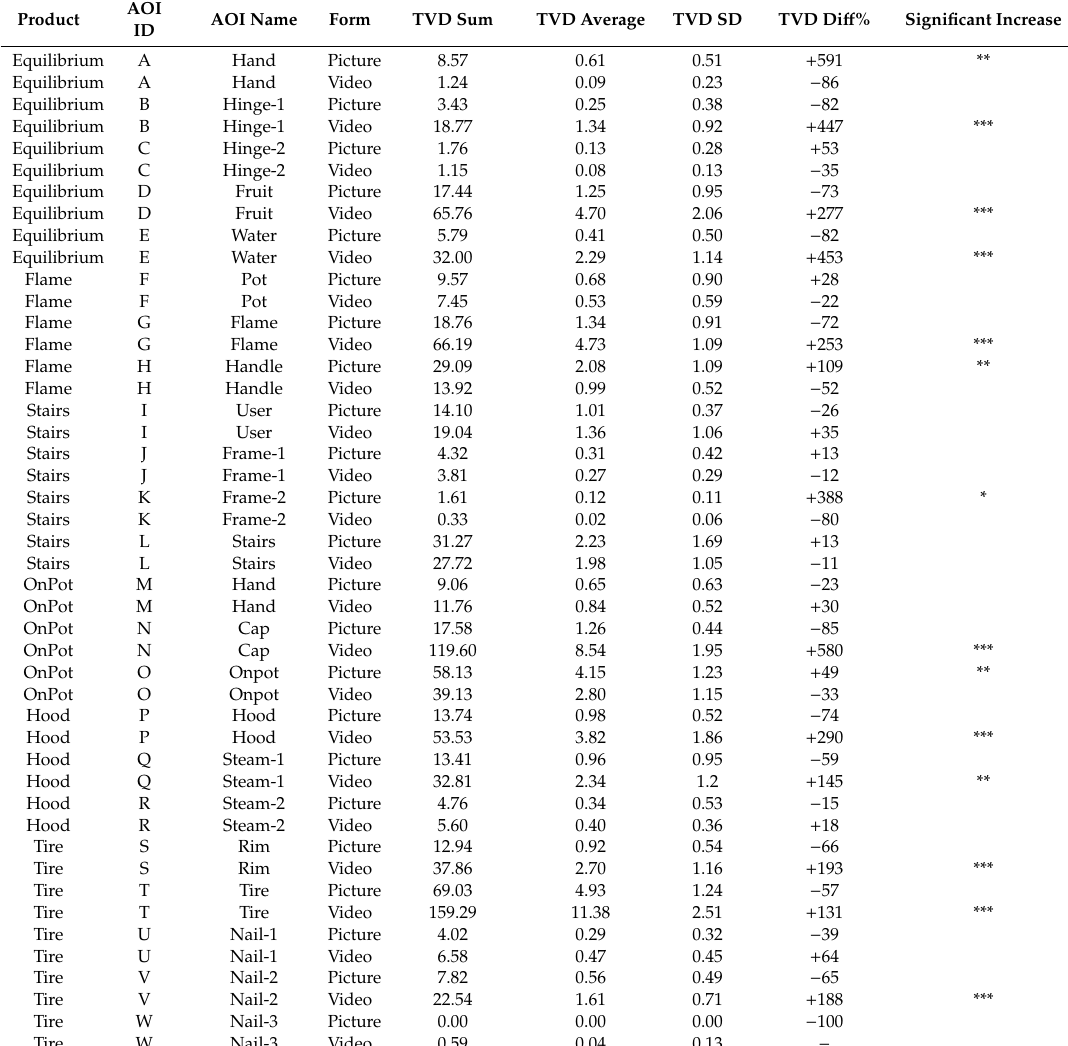
Table 3. Summary of results concerning the Total Visit Duration for each Area of Interest present in both pictures and videos of the selected creative products (*** = p _value < 0.001, ** = p _value < 0.01, * = p _value <